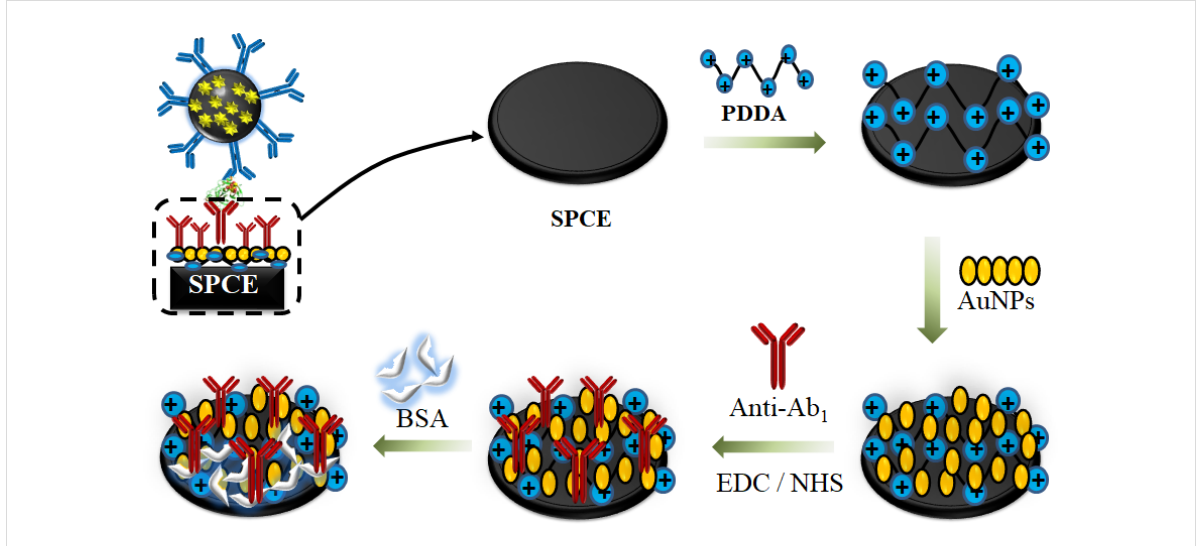
Figure 7: Electrode modification with 10 μ g·mL − 1 monoclonal antibody (Ab 1 ) using 5 μ L of 2 mg·mL − 1 PDDA and 5 μ L of AuNP-GSH. To activate the carboxyl groups from AuNP-GSH and ensure a stable covalent binding of antibodies, EDC/NHS was used (0.4 mol·L − 1 EDC and 0.1 mol·L − 1